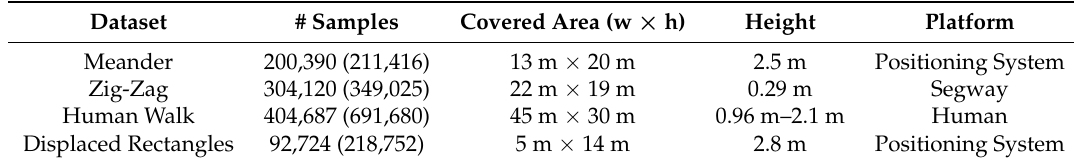
Table 1. Description of datasets